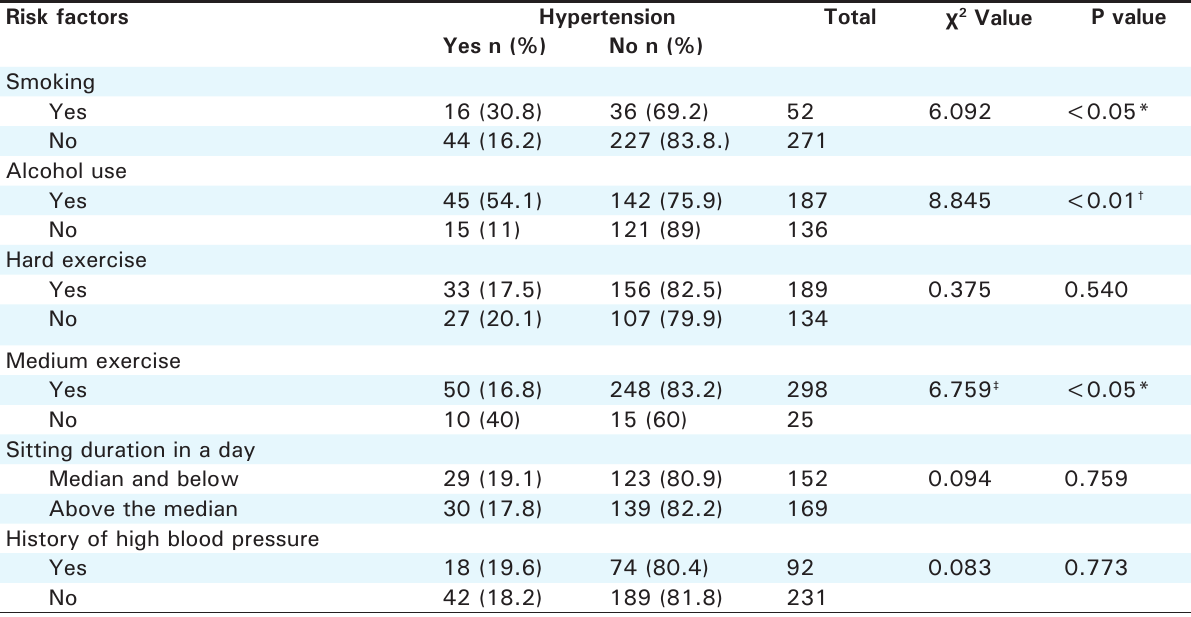
Table 2. Association of the risk factors for hypertension among government